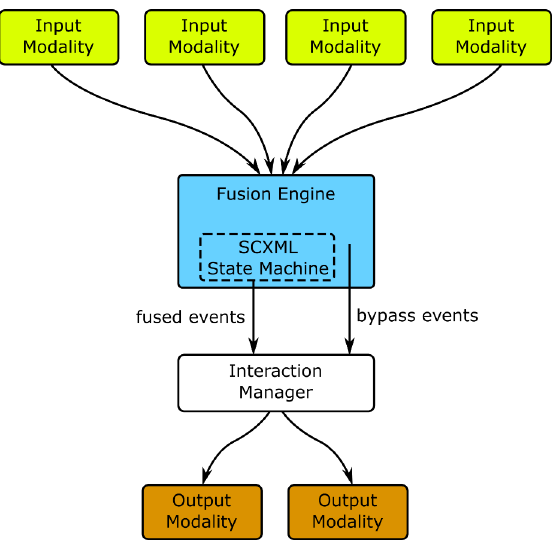
Figure 6. Multimodal Fusion Architecture. Input modalities send events to the fusion engine, the events can be fused into new ones or the fusion engine can directly pass them to the Interaction Manager. Then, the Interaction Manager interprets the events from modalities and the fused events.